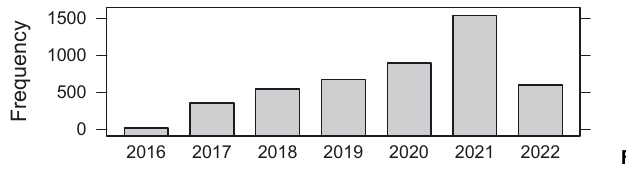
Figure 8: Usage frequency ∼ year (May